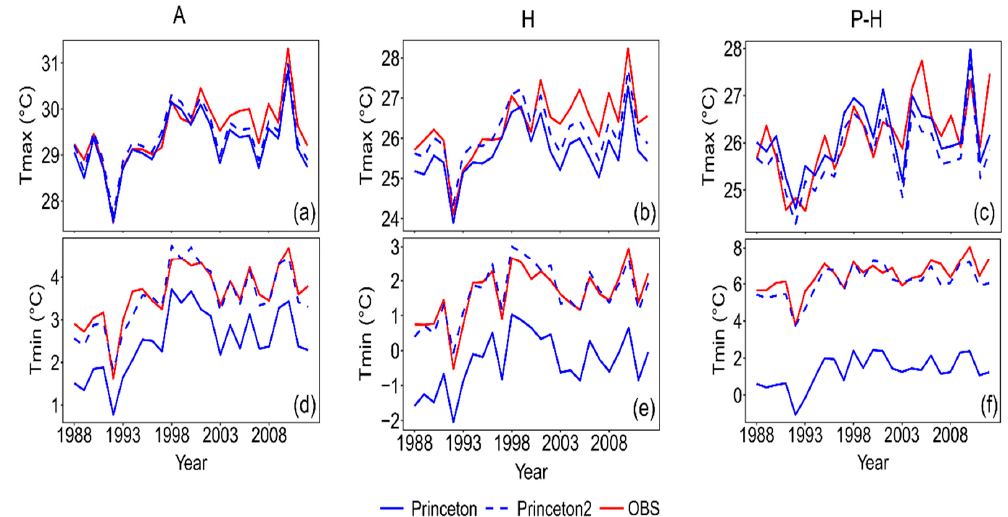
Figure 7. Pre ‐ and post ‐ adjusted time series of ( a – c ) annual maximum temperature and ( d – f ) minimum temperature at station points in the three climate zones Arid (A), Humid (H), and Per ‐ Humid (P ‐ H) zones from 1988 to 2012 for Princeton. The solid blue line represents the original gridded data, the dashed blue line represents the adjusted gridded data, while the solid red line represents station data (OBS).